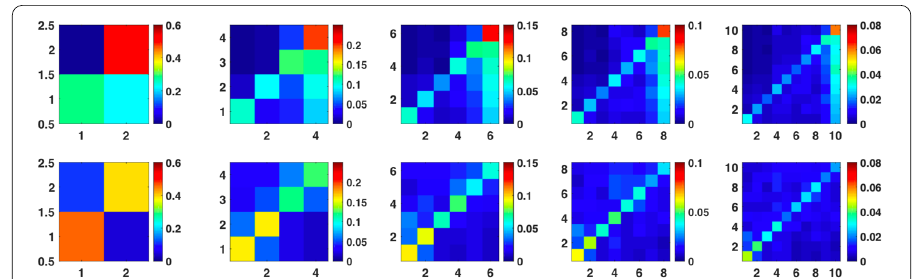
Figure 15 Mixing matrices of (Top) purchase and (Bottom) Twitter mention networks for extreme neighborhoods in terms of socio-economic status group for the Latin American metropolitan area. The columns from left to right correspond to the consideration of 1, 2, 3, 4 and 5 extreme groups on both the low and high socio-economic distribution